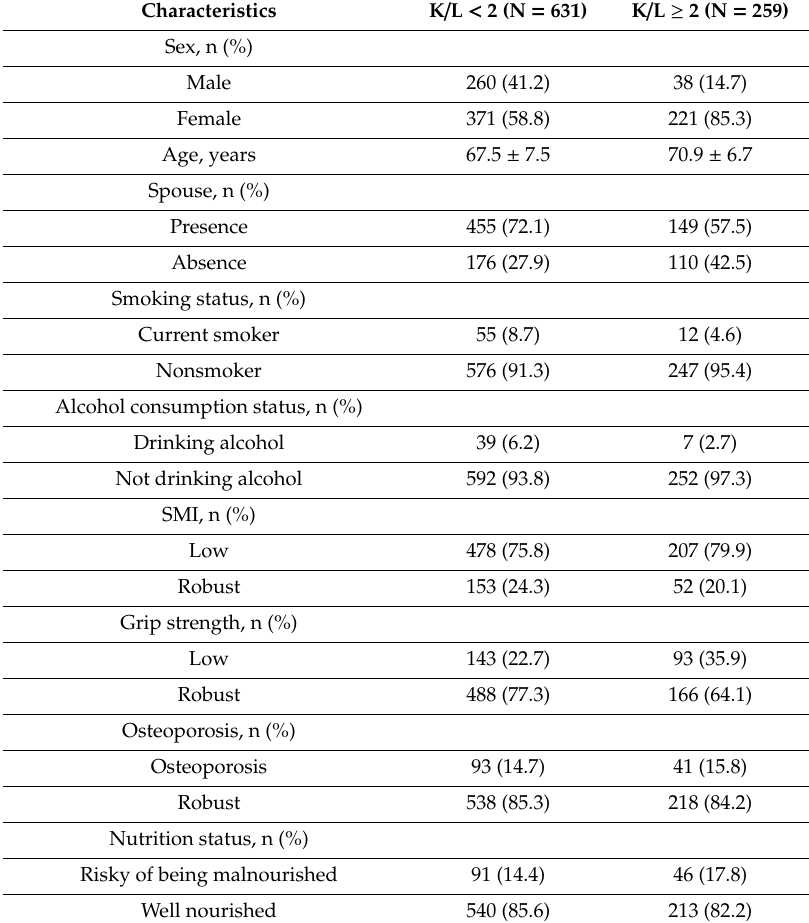
Table 1. Demographics and clinical characteristics of the study population (N =